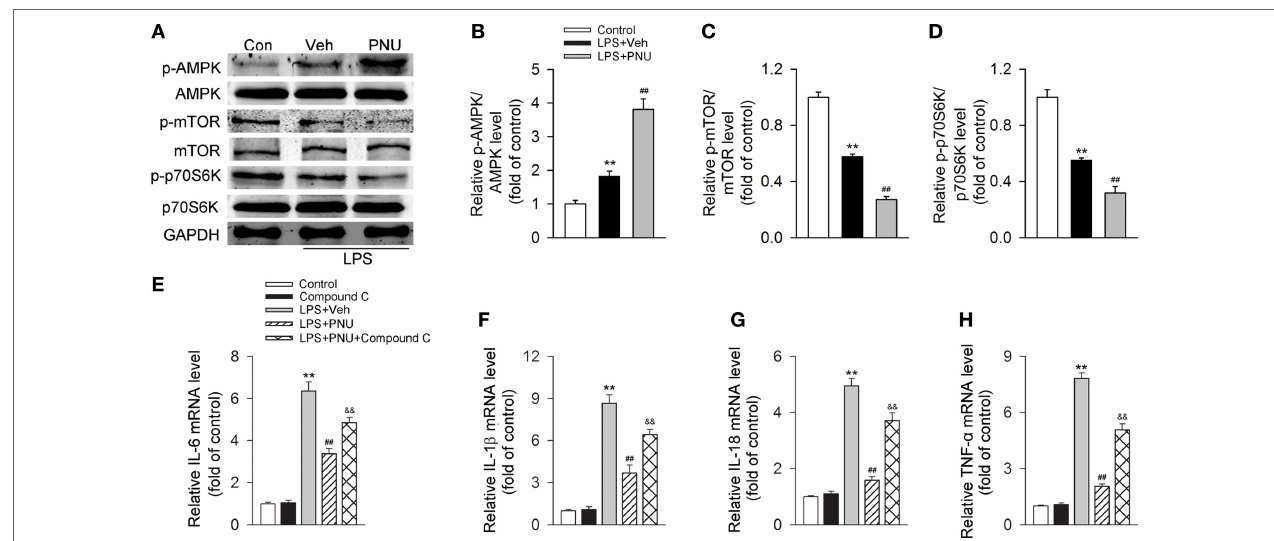
FigUre 8 | Participation of the aMPK–mTOr–p70s6K axis in the anti-inflammatory effect of PnU282987 in BV2 microglia stimulated with lipopolysaccharide (lPs) . BV2 microglia were pretreated with vehicle or PNU282987 (10 µM) and then challenged with LPS (100 ng/ml). (a) Levels of p-AMPK/ AMPK, p-mTOR/mTOR, and p-p70S6K/p70S6K ratios were detected by Western blotting. PNU282987 significantly enhanced the ratios of p-AMPK/AMPK, p-mTOR/mTOR, and p-p70S6K/p70S6K compared with vehicle ( n = 6 per group). (B–D) Quantitative analysis of relative levels of p-AMPK/AMPK, p-mTOR/mTOR, and p-p70S6K/p70S6K ratios. ** P < 0.01 vs normal, ## P < 0.01 vs Veh. (e–h) Production of interleukin-6 (IL-6), IL-1 β , IL-18, and tumor necrosis factor- α (TNF- α ) in mRNA level were detected by real-time PCR. The blockade of the AMPK–mTOR–p70S6K signaling pathway with compound C (10 µM) significantly increased the production of IL-6, IL-1 β , IL-18, and TNF- α in mRNA level ( n = 6 per group). ** P < 0.01 vs normal, ## P < 0.01 vs Veh. Veh, vehicle; PNU,